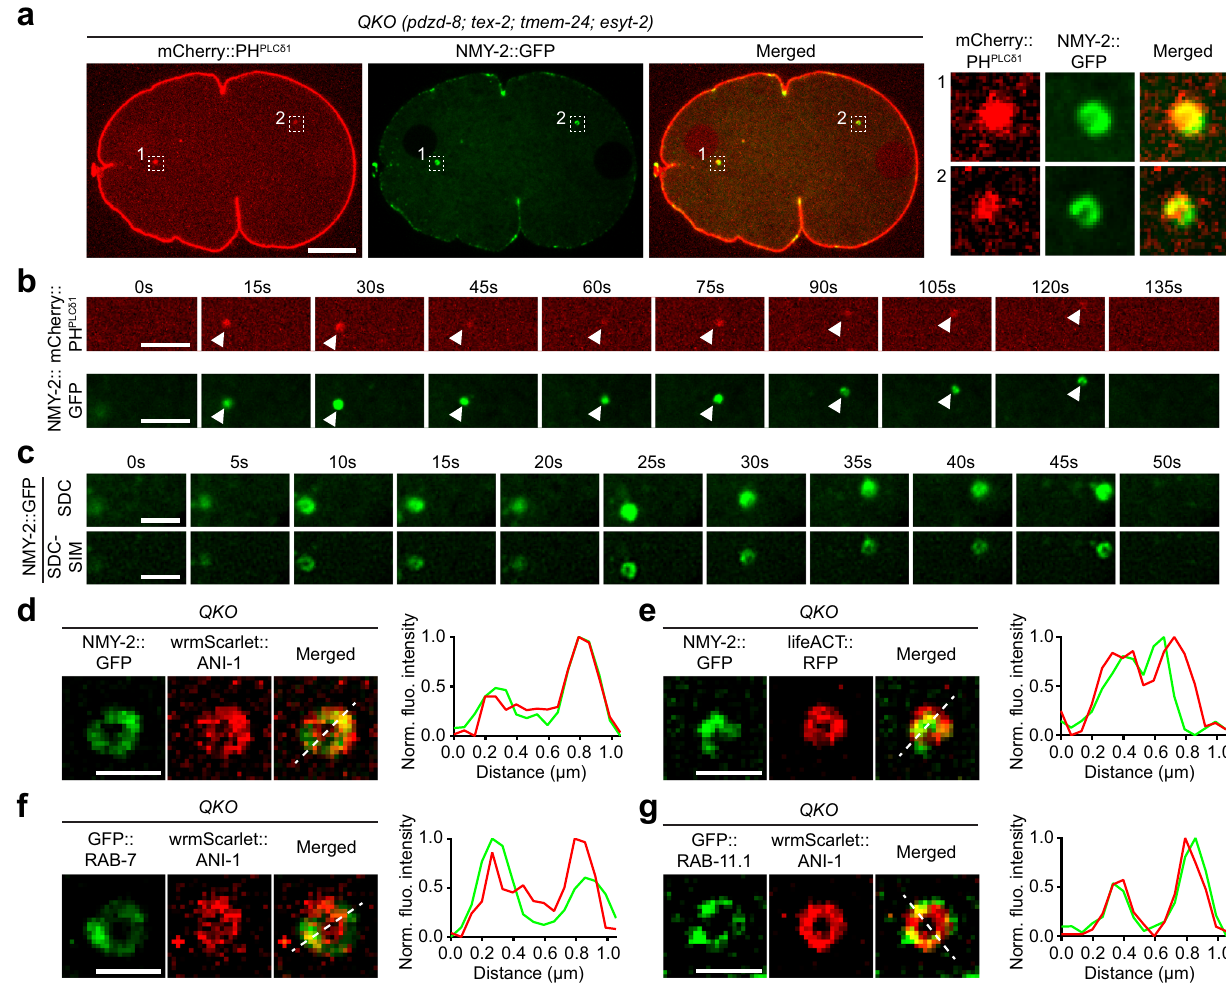
Fig. 2 Aberrant recruitment of proteins involved in actomyosin contraction to PI(4,5)P 2 -positive endosomal membranes in the absence of SMP proteins. a Left: A representative live spinning disc confocal (SDC) image of an equatorial plane of an early embryo from a mutant lacking all the four SMP proteins [quadruple knock-out: QKO (pdzd-8; tex-2; tmem-24; esyt-2) ], co-expressing PI(4,5)P 2 biosensor (mCherry::PH PLC δ 1 ) and NMY-2-tagged with GFP (NMY-2::GFP). The image is from the polarity establishment phase. Right: Magni fi ed insets, showing PI(4,5)P 2 -positive puncta, as determined by the presence of mCherry::PH PLC δ 1 , that are outlined by indicated white dotted boxes. Scale bar, 10 μ m. b Time-lapse SDC images of a representative PI(4,5)P 2 -positive puncta from an early embryo from QKO, co-expressing mCherry::PH PLC δ 1 and NMY-2::GFP, over the period of 2min. White arrowheads indicate the positions of the PI(4,5)P 2 -positive puncta. Note the extensive overlap of NMY-2::GFP signals with the PI(4,5)P 2 -positive puncta. Scale bars, 5 μ m. c Time-lapse images of representative NMY-2::GFP puncta from an early embryo from QKO over the period of 50s. Top panel: images from SDC microscopy. Bottom panel: images from SDC structure illumination microscopy (SDC-SIM). Note the lumen inside the NMY-2::GFP puncta in SDC-SIM images. Scale bars, 5 μ m. d , e Left: Live SDC-SIM images of early embryos from QKO, expressing NMY-2::GFP together with either d wrmScarlet-tagged ANI-1 (wrmScarlet::ANI-1) or e lifeACT-tagged with RFP (lifeACT::RFP), showing representative NMY-2::GFP puncta that are co-localized with the marker proteins as indicated. Right: Line scan pro fi les of NMY-2::GFP (green) and either d wrmScarlet::ANI-1 or e lifeACT::RFP (red) fl uorescence signals along the white dotted lines as indicated. Scale bars, 1 μ m. f , g Left: Live SDC-SIM images of early embryos from QKO, expressing wrmScarlet::ANI-1 together with either f GFP-tagged RAB-7 (GFP::RAB-7) or g GFP-tagged RAB-11.1 (GFP::RAB-11.1), showing representative wrmScarlet::ANI-1 puncta that are co-localized with the marker proteins as indicated. Right: Line scan pro fi les of wrmScarlet::ANI-1 (red) and either f GFP::RAB-7 or g GFP::RAB-11.1 (green) fl uorescence signals along the white dotted lines as indicated. Scale bars, 1 μ